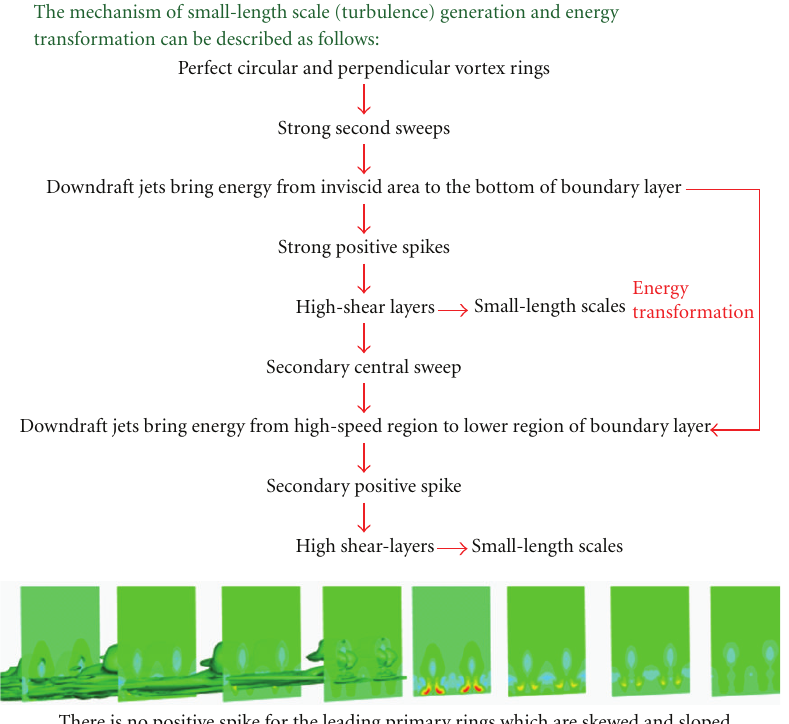
Figure 32: Energy transfer paths and universal structure for turbulence.